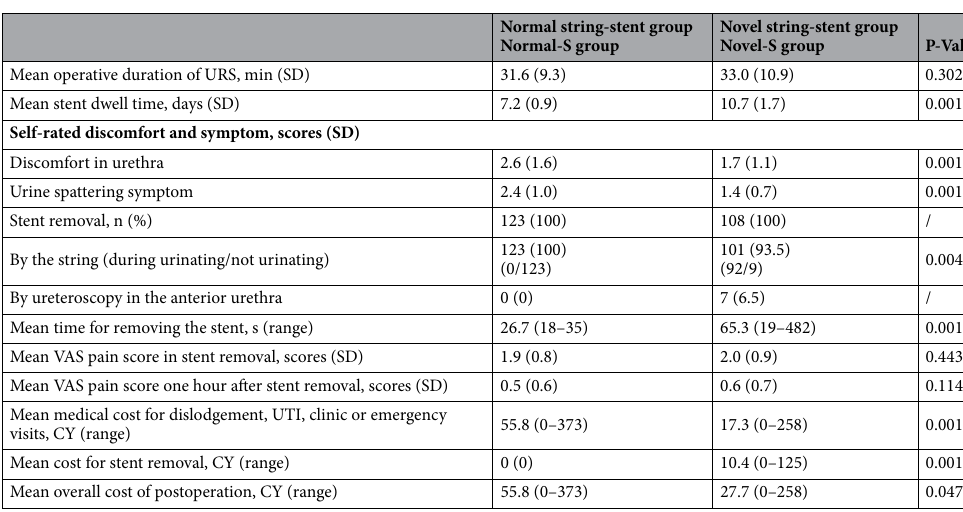
Table 2. Stent indwelling/removal-related data and medical